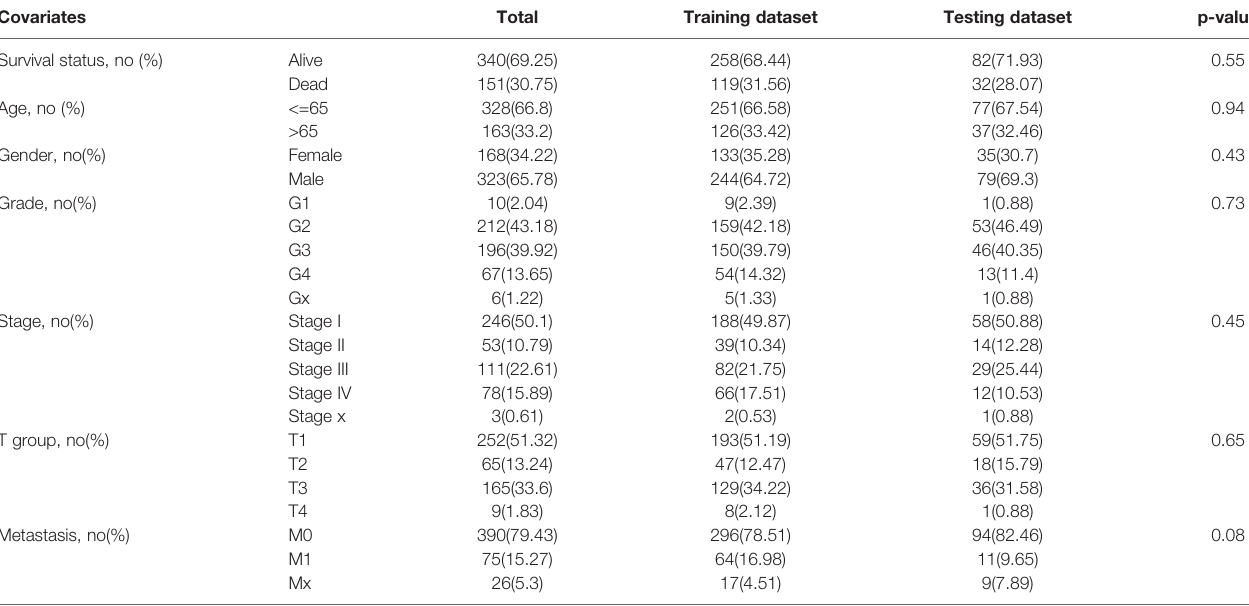
TABLE 1 | Clinical information of patients in training and testing dataset and chi-square test between two groups. Covariates Total Training